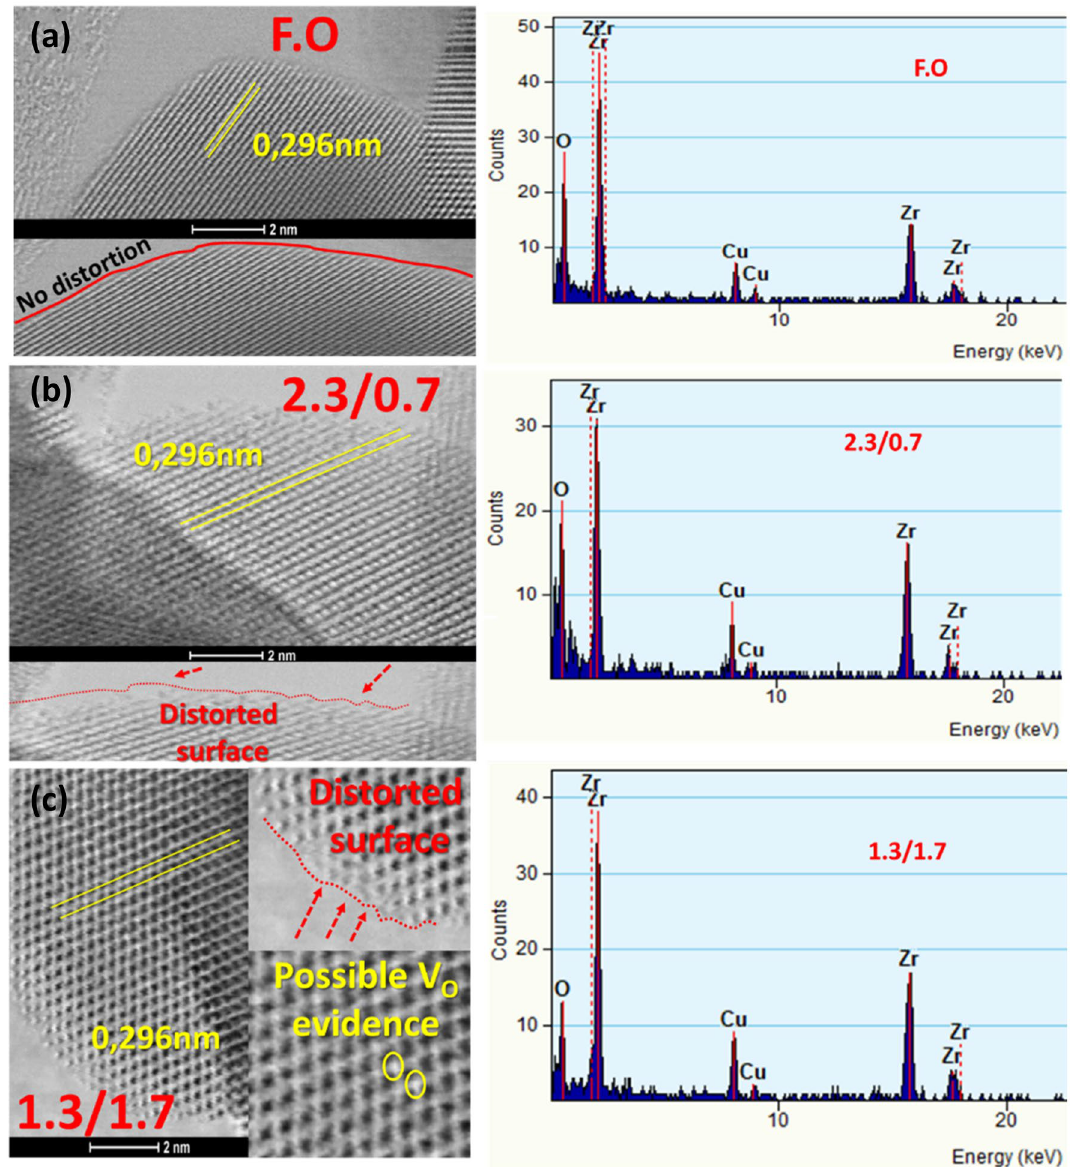
Figure 3. STEM images and EDX spectra of ( a ) F.O. ( b ) 2.3/0.7 and ( c ) 1.3/1.7